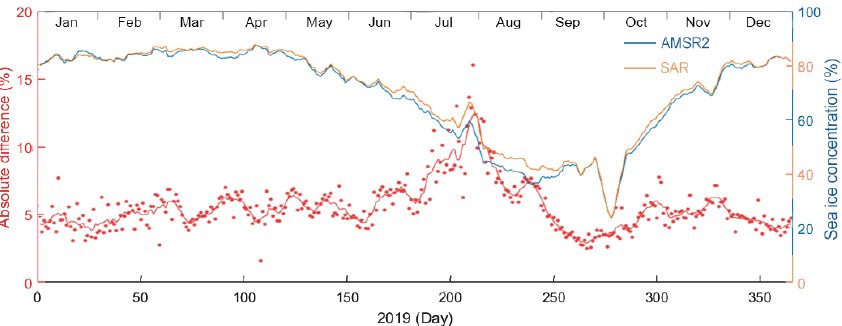
Figure 12. Comparison between the S1-derived Arctic sea ice concentration data and AMSR2 data for the whole year of 2019. The red dots reflect the absolute daily difference, and the red line is the 7d average absolute difference. The blue line is the 7d average sea ice concentration in the S1-covered area calculated based on the AMSR2 data, and the orange line is the 7d average sea ice concentration calculated based on S1-derived